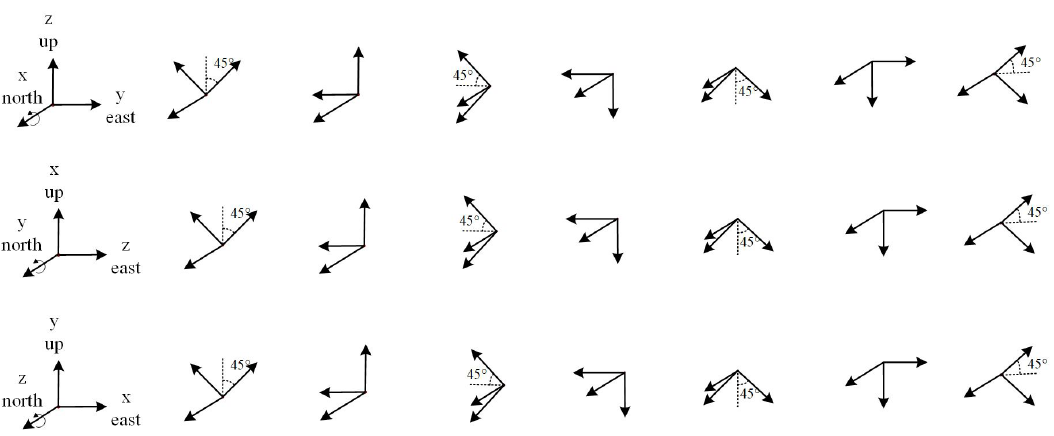
Figure 1. Scheme of measurement